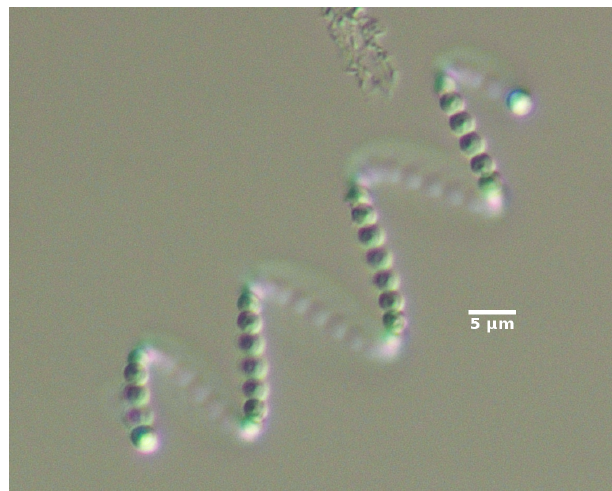
Figure A4. Filamentous blue-green algae; cf. Anabaena sp.